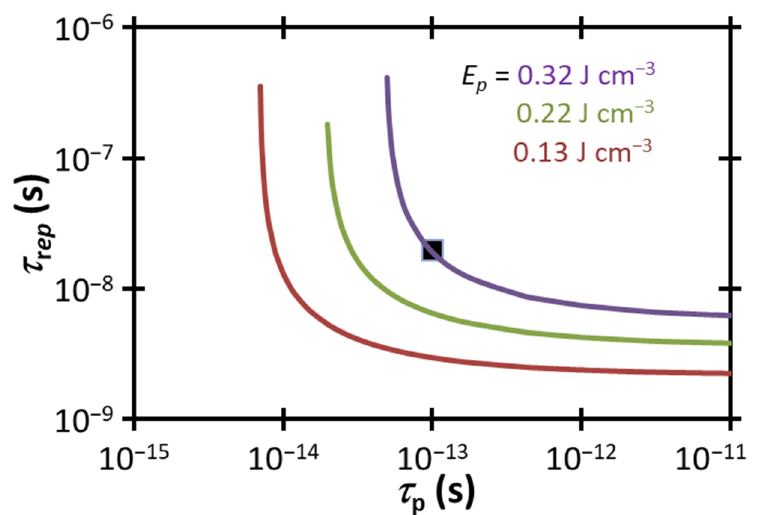
Figure 5. Peak energy density (cid:1831) (cid:3043) to achieve ∇(cid:1846) (cid:3032)(cid:3043) , the estimated temperature gradient necessary for direct electropermeabilization, as a function of pulse duration (cid:2028) (cid:3043) and time between pulses (cid:2028) (cid:3045)(cid:3032)(cid:3043) . Regions below the curves, indicating a sufficiently fast repetition rate, represent ∇(cid:1846) (cid:3408) ∇(cid:1846) (cid:3032)(cid:3043) for the given (cid:1831) (cid:3043) . The black square represents the experimental condition of 1550 nm, (cid:2028) (cid:3045)(cid:3032)(cid:3043) (cid:3404) 20 ns, (cid:1872) (cid:3043) (cid:3404) 100 fs, and 0.13 (cid:3407) (cid:1831) (cid:3043) (cid:3407) 0.22 J cm (cid:2879)(cid:2871) . Satisfying the electropermeabilization threshold for the current experimental (cid:2028) (cid:3043) and (cid:2028) (cid:3045)(cid:3032)(cid:3043) would require increasing (cid:1831) (cid:3043) to 0.32 J cm (cid:2879)(cid:2871) .